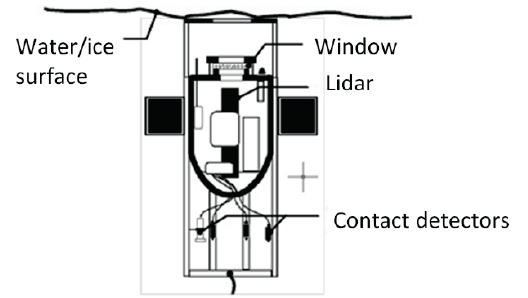
Fig. 10 Combined measuring system (lidar and contact